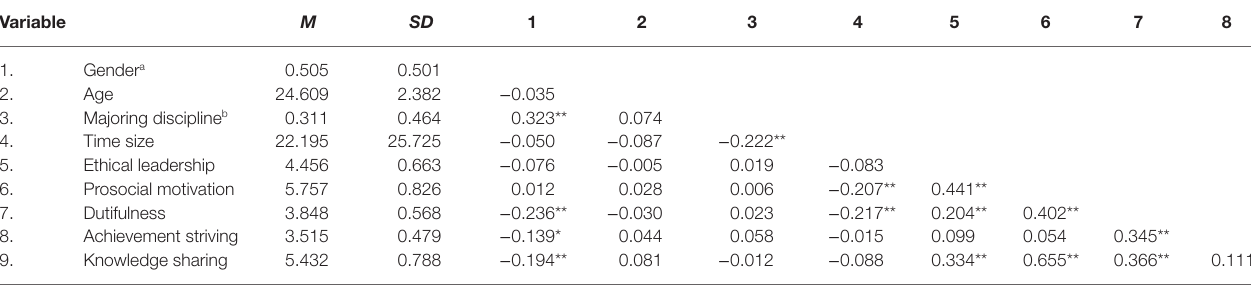
TABLE 2 | Means, SD, and correlations among variables.